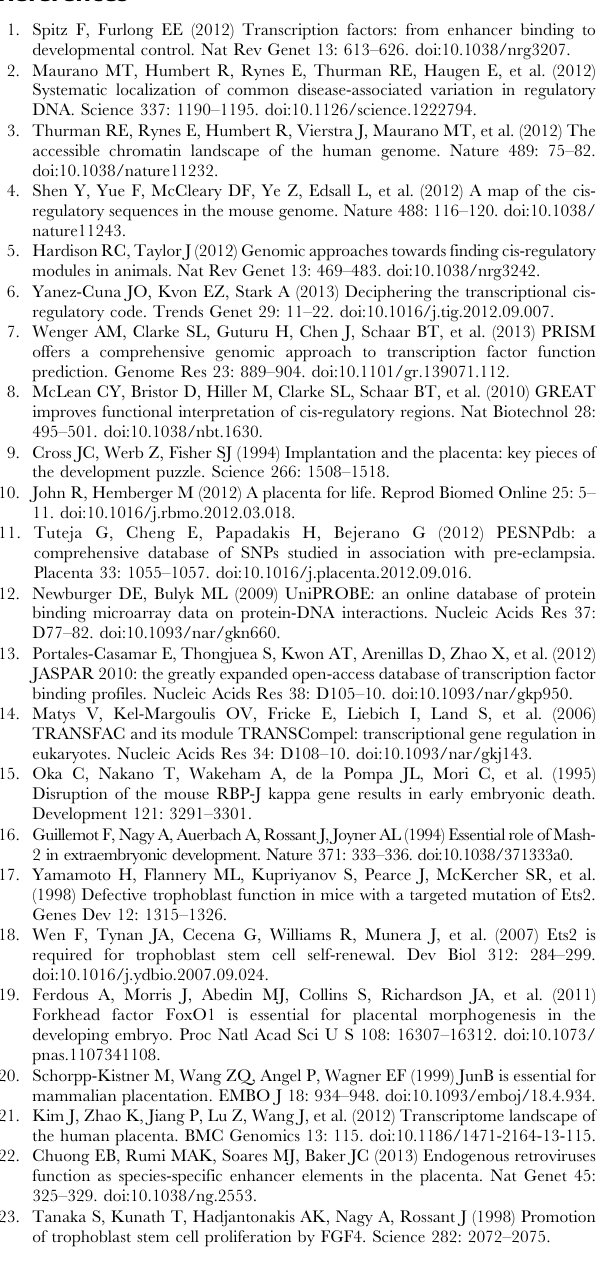
Table S13 Gene counts associated with terms used to identify TFs relevant for various tissues. The primary term used to identify TF enrichment for each tissue is shown in column 2, and column 3 shows the number of genes annotated with the term. For bone barrow, blood vessel, placenta, and liver, the MGI Mouse Phenotype ontology is shown, and for heart and pancreas the GO Biological Process term is shown. The term used for pancreas has a much lower gene count than other tissues